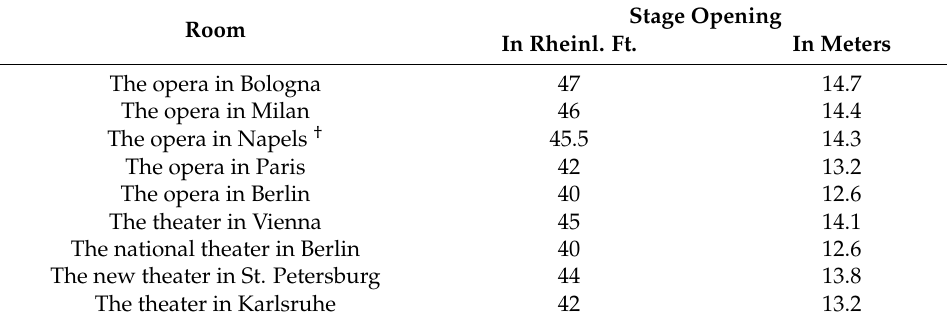
Table 1. Stage openings of several operas and theaters according to